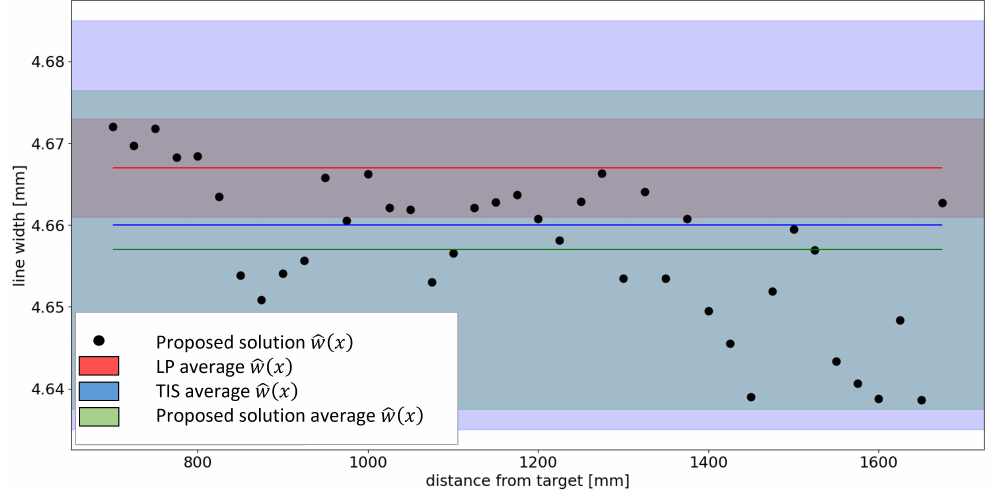
ˆ w ( x ) calculated using the proposed solution according to the distance x of the camera from the target. In the graph, the results of the measurements carried out are superimposed with the LP and TIS in terms of average value and uncertainty